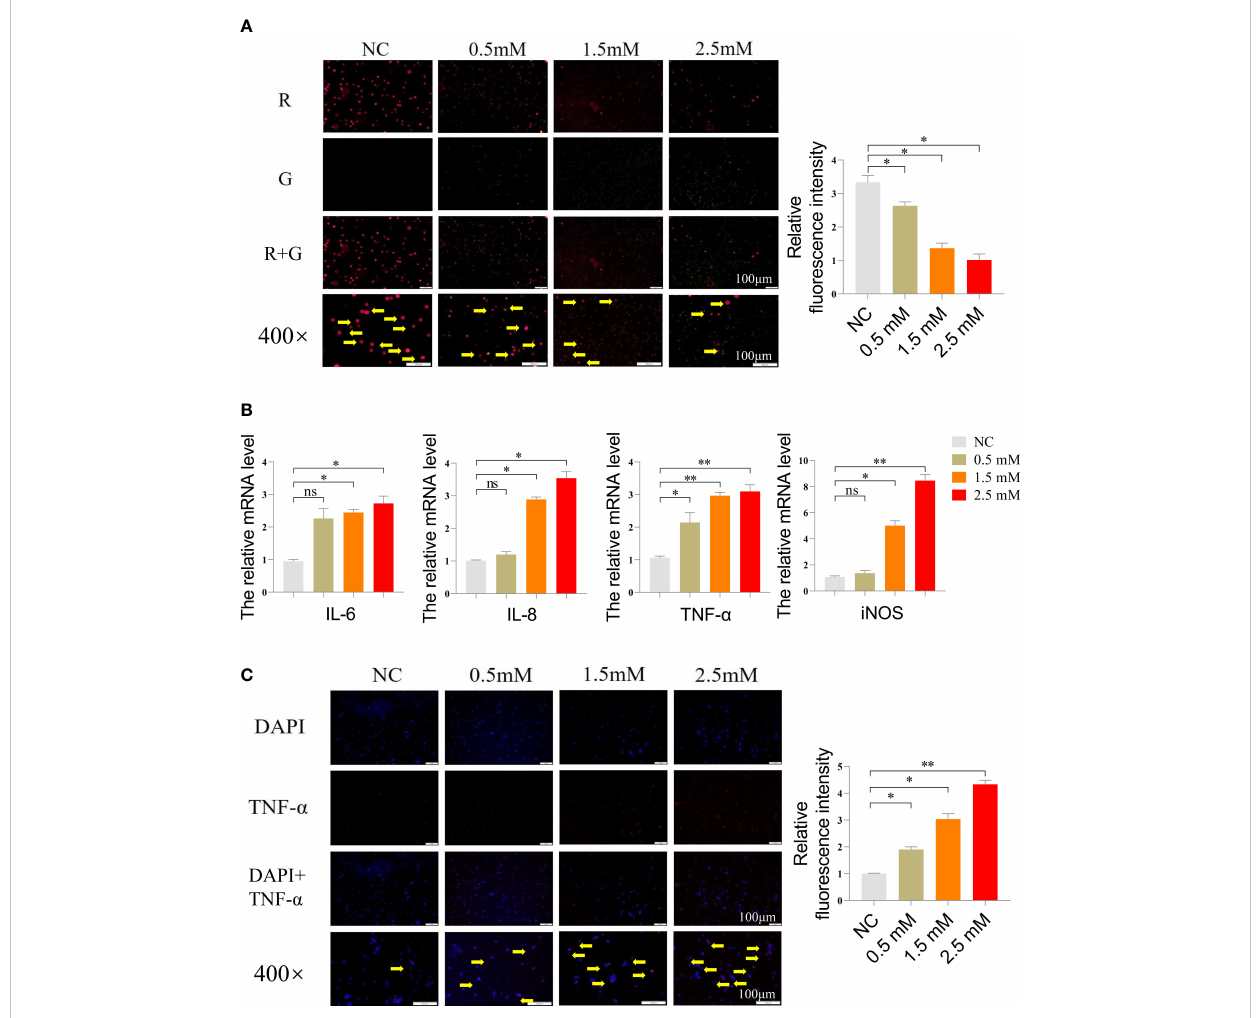
FIGURE 2 (A) Mitochondrial membrane potential detection of spleen lymphocytes exposed to different concentrations of NiCl (pointed by the yellow arrow) to green dots indicates a decrease in mitochondrial membrane potential. (B) The mRNA expression of in fl ammation- related genes in spleen lymphocytes exposed to different concentrations of NiCl 2 , ns represents no statistical difference between the two groups, * represents signi fi cant difference between the two groups (P<0.05), and ** represents extremely signi fi cant difference between the two groups (P<0.01). (C) Immuno fl uorescence detection of TNF- a in spleen lymphocytes exposed to different concentrations of NiCl 2 , blue dots represent cell nucleus, red dots represent the expression of TNF- a